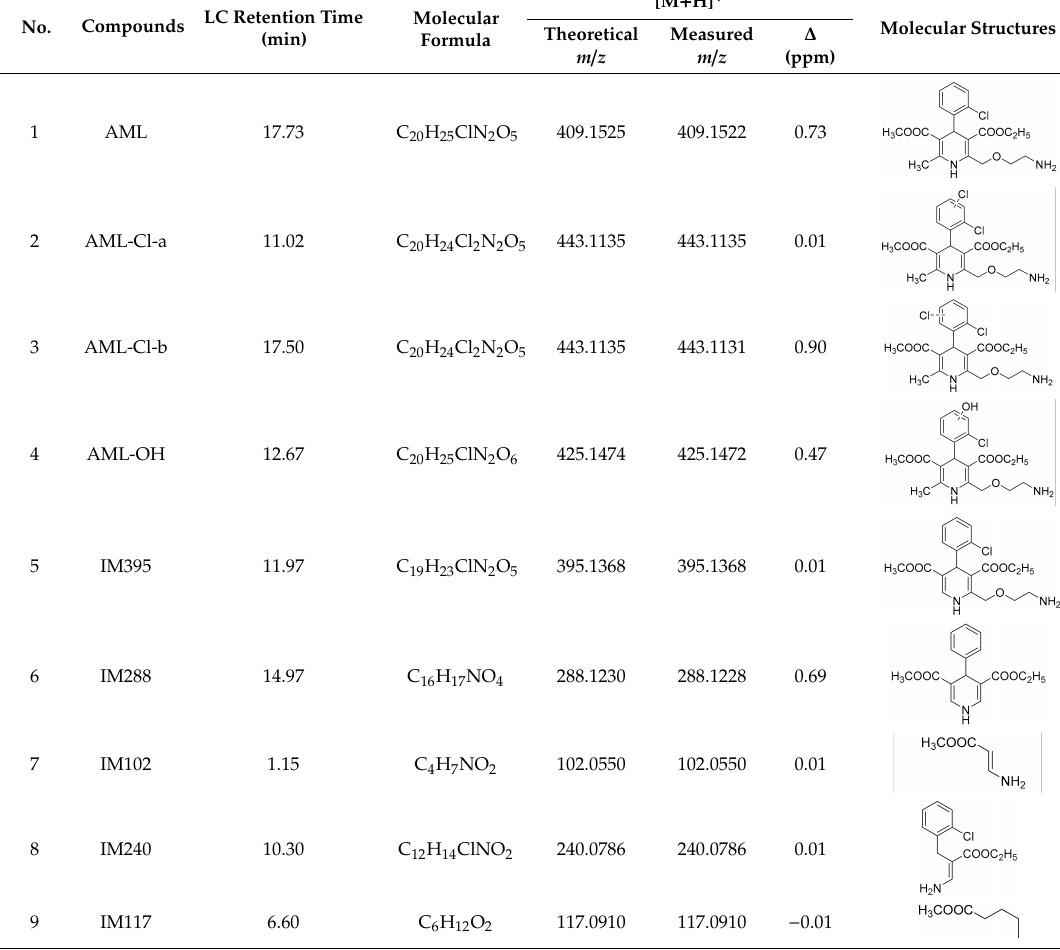
Table 1. Molecular formula, retention time, high-resolution accurate masses ([M + H] + ) with errors ( ∆ ), and molecular structures of AML and its degradation products detected by HRMS. LC Retention Time No. Compounds